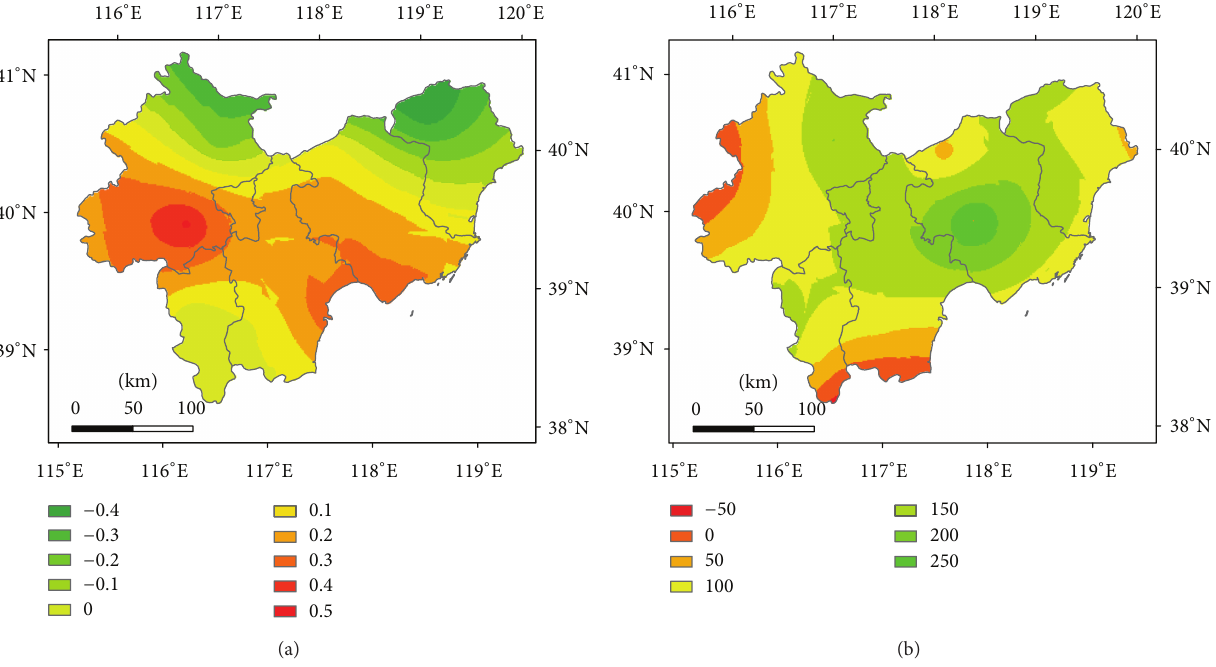
and precipitation to a certain extent in the Beijing-Tianjin- Tangshan Metropolitan